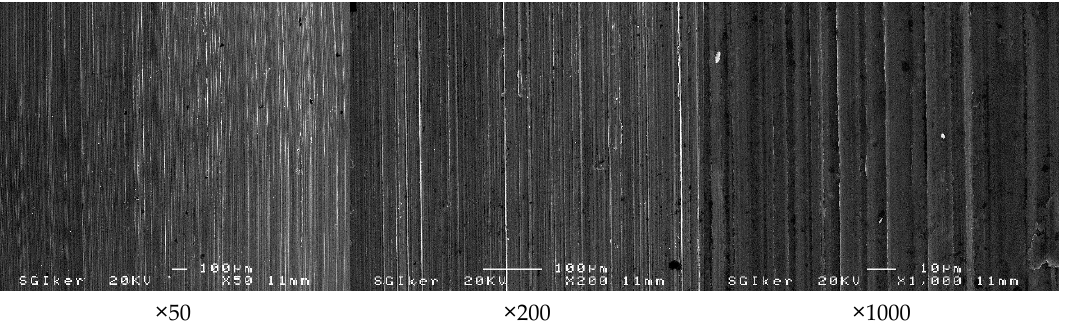
Figure 17. AA-5083-N2 disk. Figure 17. AA ‐ 5083 ‐ N2 disk. Figure 17. AA ‐ 5083 ‐ N2 disk.